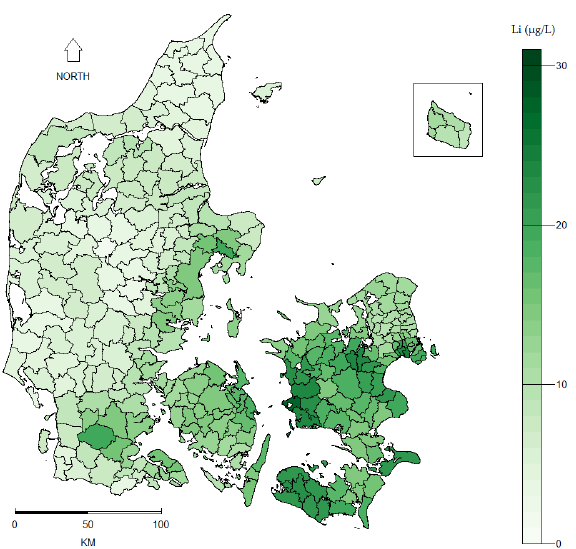
Figure 3. Mean municipality lithium (Li in µ g/L) levels in Danish drinking water based on interpolation of 151 measurements (Figure 2A) sampled at Danish waterworks between 2009 and 2013. Table 2. Baseline characteristics of the study population on 1 January 1991 by five-year time-weighted average (TWA) lithium exposure level.